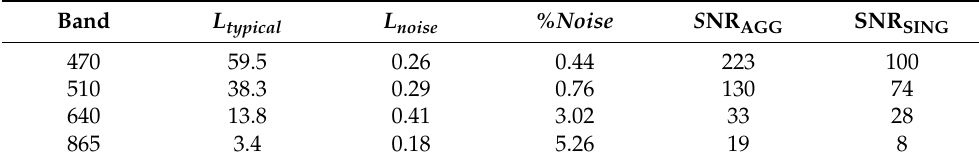
Table 2. Visible and near ‐ infrared Himawari ‐ 8 𝐿 (cid:3047)(cid:3052)(cid:3043)(cid:3036)(cid:3030)(cid:3028)(cid:3039) and 𝐿 (cid:3041)(cid:3042)(cid:3036)(cid:3046)(cid:3032) (cid:4666) W m (cid:2879)(cid:2870) sr (cid:2879)(cid:2869) µm (cid:2879)(cid:2869) (cid:4667) and associ ‐ ated percentage noise ( %Noise ) for SNR AGG at 𝜃 (cid:3046) = 45° ± 1°. Calculated SNR SING at 𝜃 (cid:3046) = 45° ± 1° val ‐ ues were added for comparison.